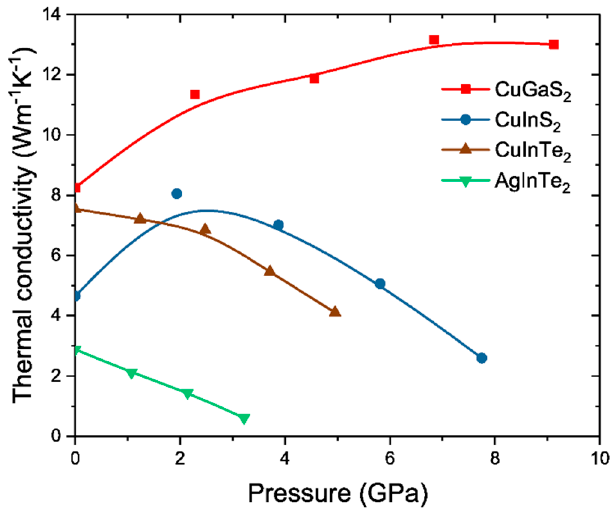
Figure 2. Thermal conductivity at 300 K for CuGaS 2 , CuInS 2 , CuInTe 2 , and AgInTe 2 under compression. The solid lines connecting the data points serve as a guide to the eye.